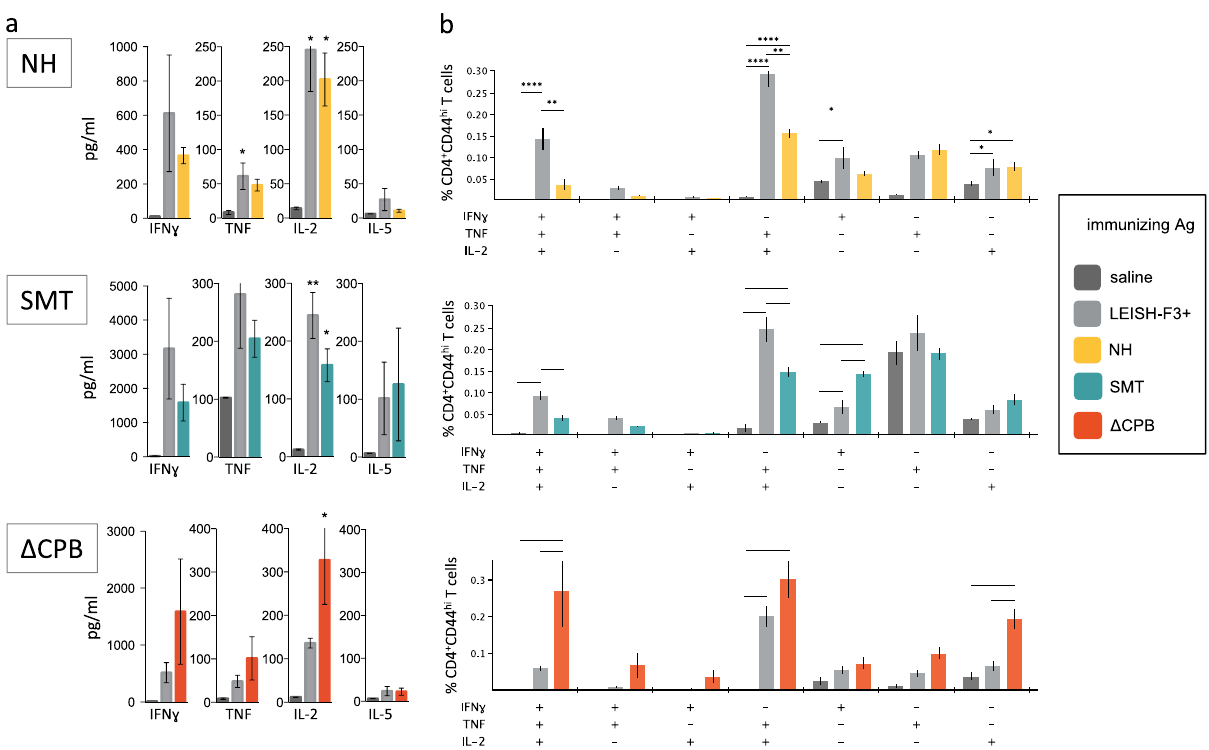
Fig. 3 Immune recognition of each component within LEISH-F3+. C57BL/6 mice were injected a total of three times with 1 μ g LEISH-F3+ protein, or a molar equivalence of the individual NH, SMT and Δ CPB proteins alone, formulated with GLA-SE. One month after the fi nal immunization spleens were removed to prepare single cell suspensions ( n = 3). In a , cells were incubated with antigen indicated in the box for 4 days then cytokine content in the culture supernatant determined by ELISA. In b , cells were subjected to fl ow cytometry to identify antigen- experienced CD4 T cells and the cytokine protection pro fi le (various combinations of IFN- γ , IL-2, or TNF). Data are shown as mean and s.e.m, three mice per group. Data are representative of results obtained in two similar